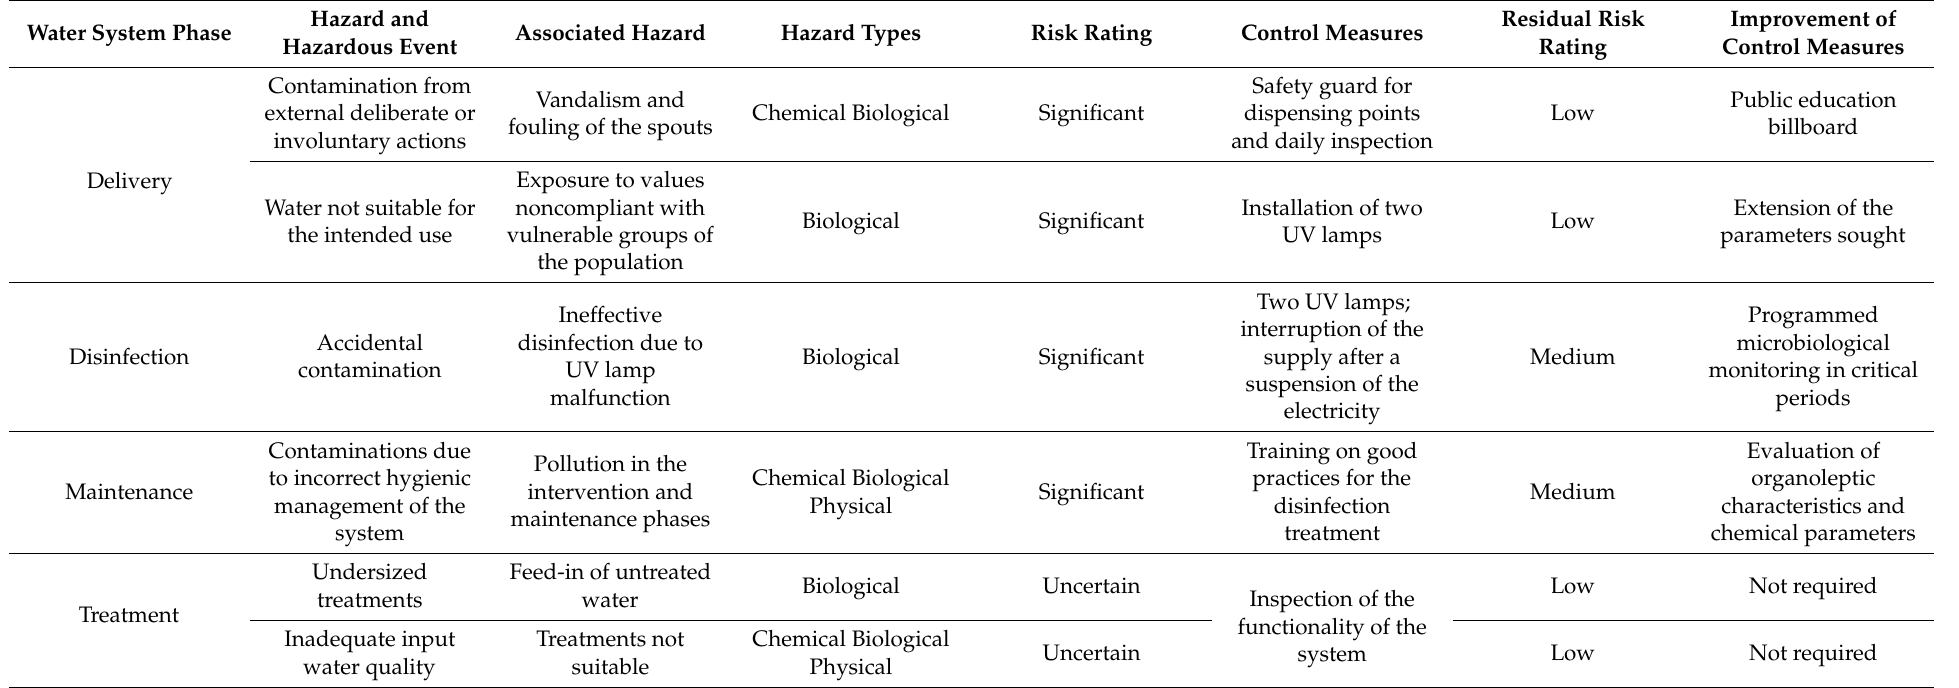
Table 1. Identification of hazards and dangerous events: Case Study